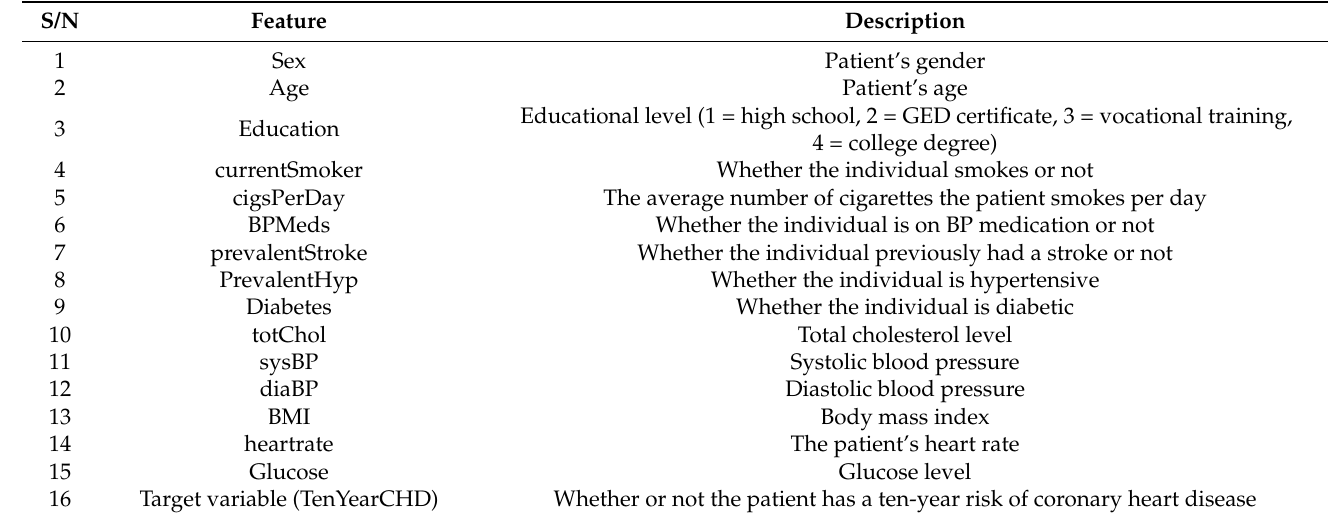
Table 2. Features in the Framingham